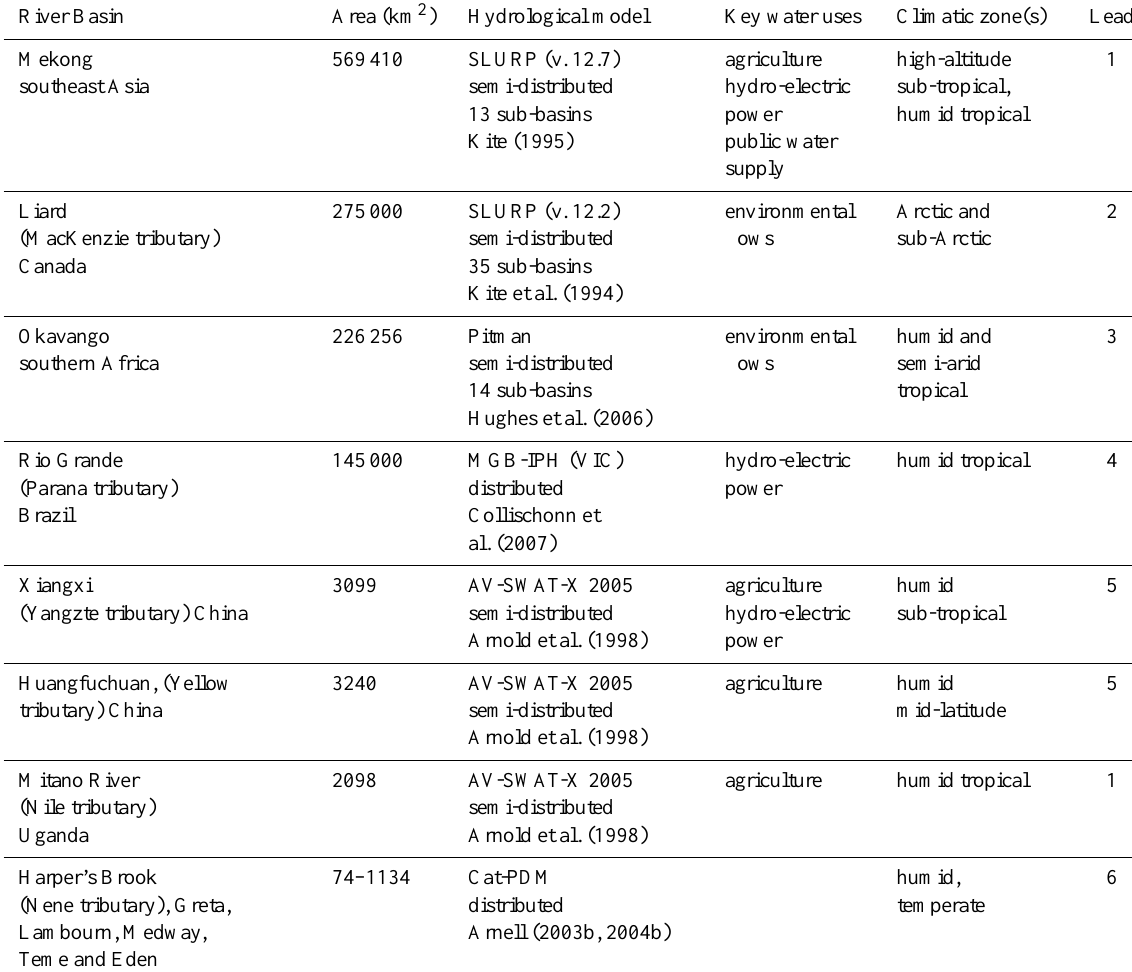
Table 1. Summary of basin characteristics and models employed in the QUEST-GSI